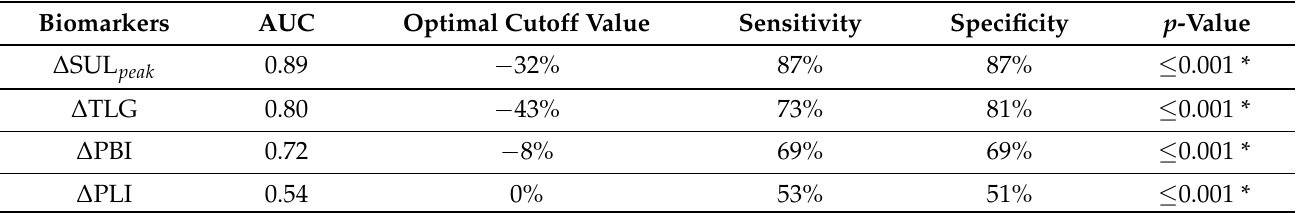
Figure 5. Receiver Operating Characteristic (ROC) curve, responders (CR or PR) vs. non-responders (SD or PD). Table 2. Biomarker for response assessment according to ROC analysis. Areas Under the Curve (AUCs) were computed on the ROC curve shown in Figure 5. The optimal cutoff value to differentiate between responder and non-responder patients was determined using the Youden’s J statistic method. Sensibility and specificity were computed for this optimal cutoff. P-values are determined using a Mann-Whitney U test for statistical difference between responder and non-responder groups defined by the optimal